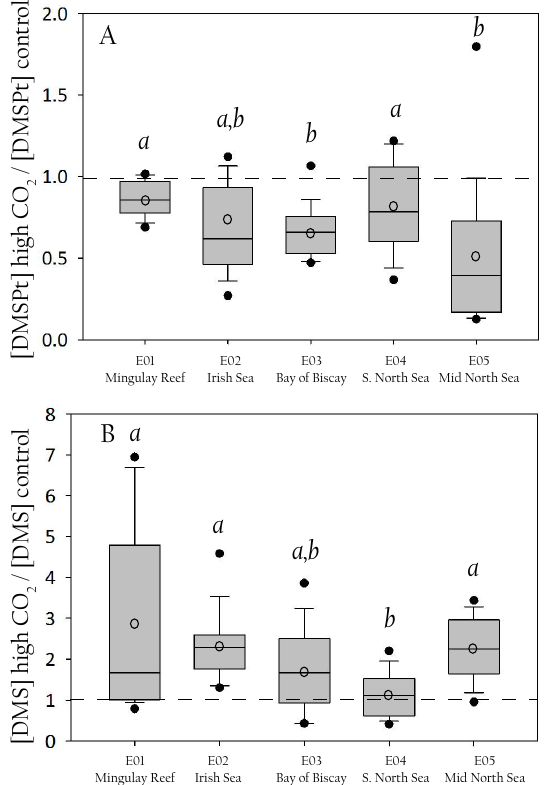
Figure 6. Box plots summarising relative differences ([ x ] high CO 2 /[ x ] control) in (a) DMSPt and (b) DMS between ambient control and high-CO 2 treatments for each experimental bioassay (all data from all time points). Plots show interquartile range (box), median values (horizontal line in box), mean values (open cir- cles), range of data (error bars) and outliers (closed circles, outside 1.5 × interquartile range). Italicised letters ( a,b ) indicate statisti- cal groupings derived from one-way ANOVA and pairwise com- parisons (Tukey’s/Dunn’s, significant differences between pairs if P <0.05). Grey dashed line indicates a value of 1, i.e. no difference between ambient controls and high-CO 2